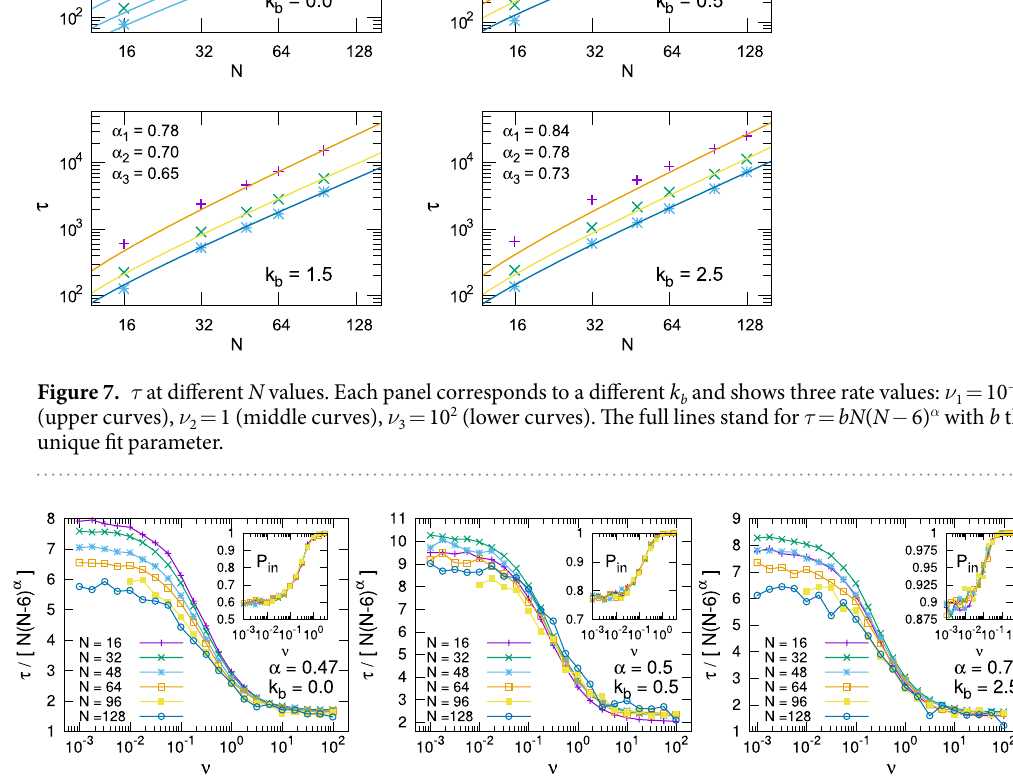
Figure 8. Scaled translocation times at three values of the polymer bending parameter k b = 0.0, 0.5 and 2.5. The inset shows the translocation probability P in for the different polymer